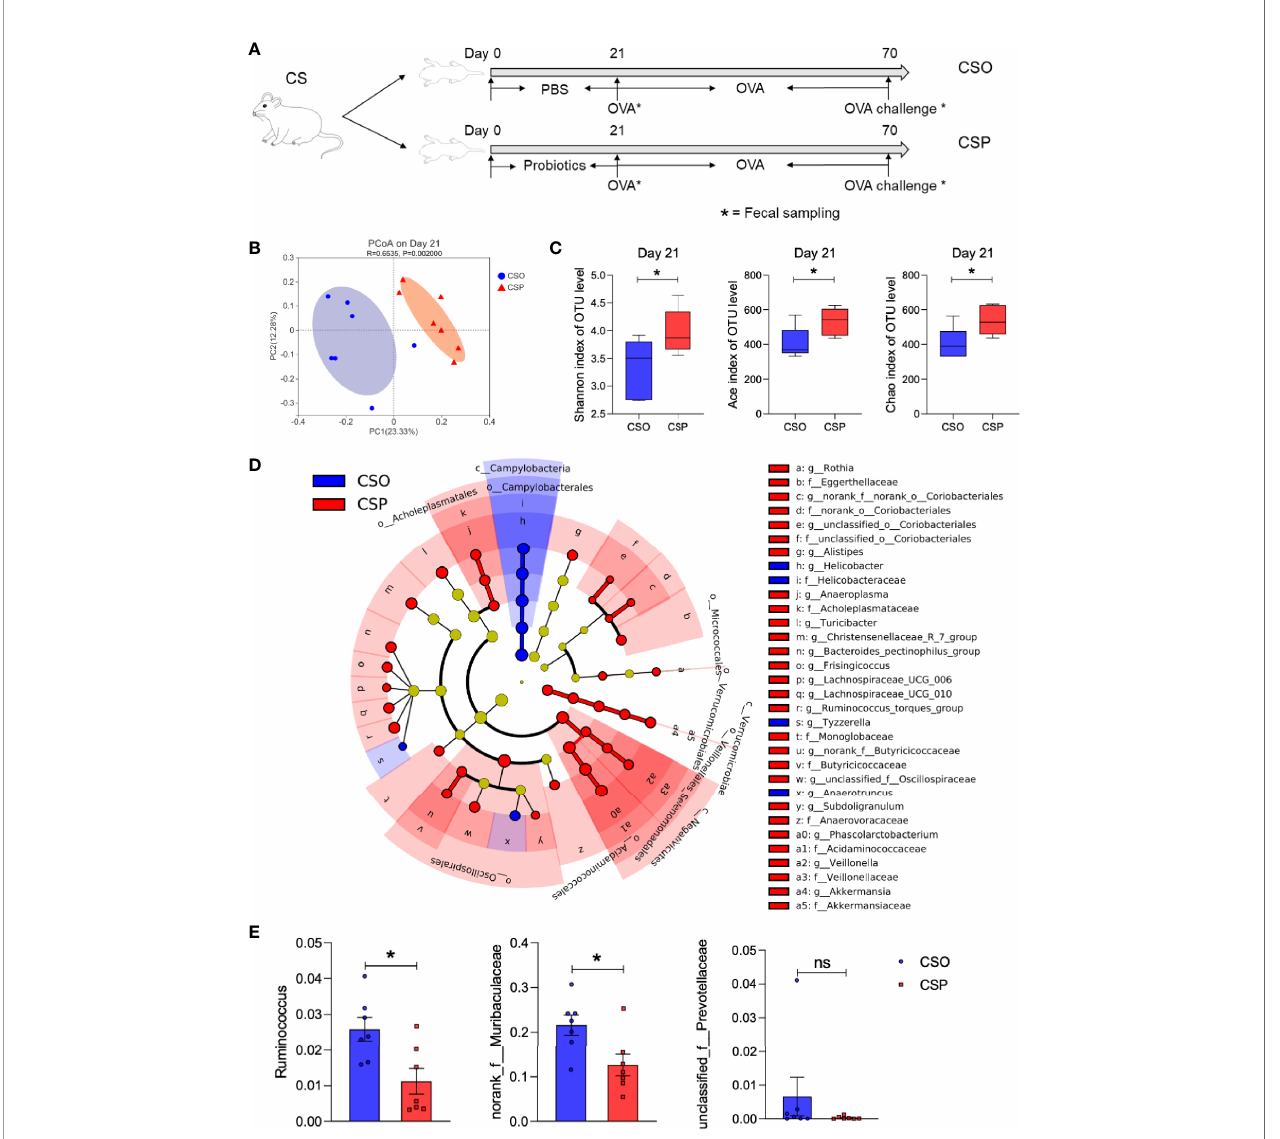
FIGURE 5 | Probiotic intervention modulates intestinal microbiota structure of CS rats. (A) Schematic diagram of CS rats submitted to probiotics intervention and food allergy. (B) PCoA of fecal microbiota composition in CSO and CSP rats on Day 21. n = 7. ANOSIM and 999 times permutation tests were utilized. (C) Shannon, Ace, and Chao indexes on Day 21. n = 7. (D) Cladogram of CS and CSP based on LEfSe analysis from phylum to genus level with the value of the Kruskal – Wallis rank-sum test set to 0.05. n = 7. (E) The relative abundance of some speci fi c microbes on Day 70. n = 7. Data are expressed as means ± SEM, statistical signi fi cance was determined by two-sided Student ’ s t-test or one way ANOVA, * P < 0.05; ns, no signi fi cance; CSO, the cesarean section offspring; CSP, cesarean section with probiotic